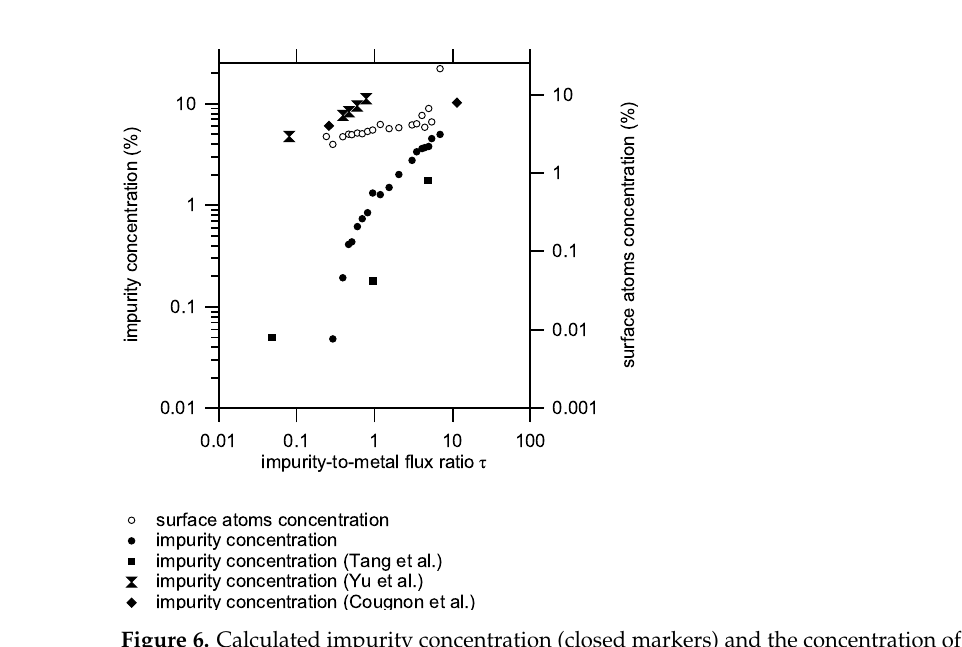
Figure 6. Calculated impurity concentration (closed markers) and the concentration of surface atoms (open markers) as a function of the impurity-to-metal flux ratio τ . Literature values are also presented based on the work of Tang et al. [23], Yu et al. [46] and Cougnon et al.